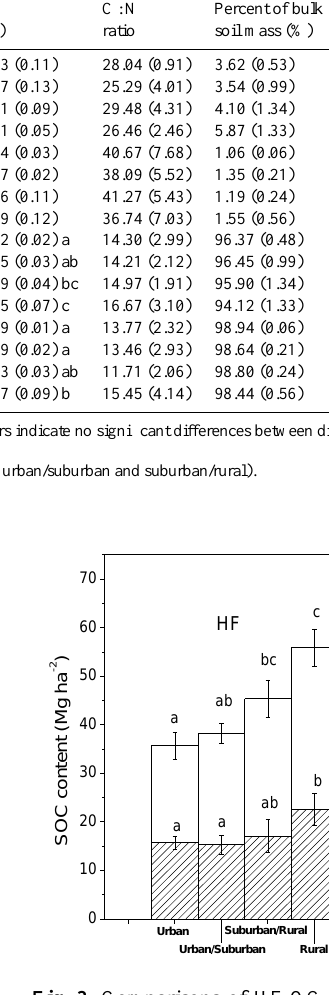
Fig. 3. Comparisons of HF-OC and LF-OC content (in 0–10 and Fig 3. Comparisons of HF-OC and LF-OC content (in 0-10 and 10-20 cm soil layer) among four 507 10–20cm soil layers) among four urbanization gradient classes. Er- urbanization gradient classes. Error bars indicate ± 1 S.E. (N = 3 for urban and rural, N=4 for 508 ror bars indicate ± 1S. E. ( N = 3 for urban and rural, N = 4 for urban/suburban and suburban/rural). Different letters denote signif- urban/suburban and suburban/rural). Different letters denote significant difference ( P ≤ 0.05) 509 icant differences ( P ≤ 0.05) between gradient classes (SNK between gradient classes (SNK test). 510